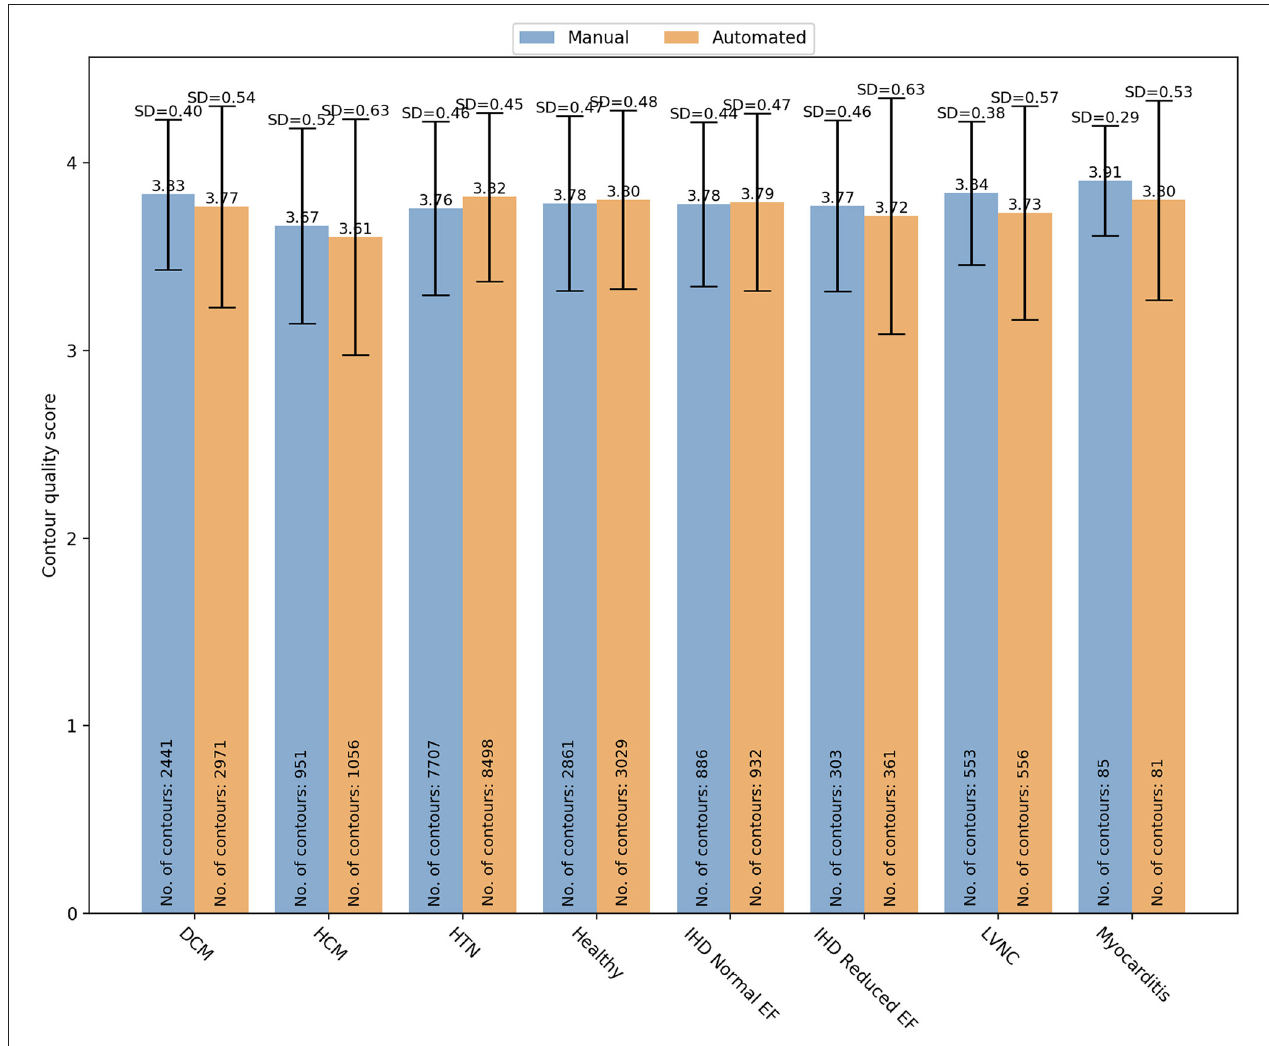
FIGURE 7 | Distribution of the overall contour quality scores by different pathologies for manual (blue) and automated (orange) segmentation. DCM, dilated cardiomyopathy; HCM, hypertrophic cardiomyopathy; HTN, hypertension; IHD, ischaemic heart disease; EF, ejection fraction; LVNC, left ventricle